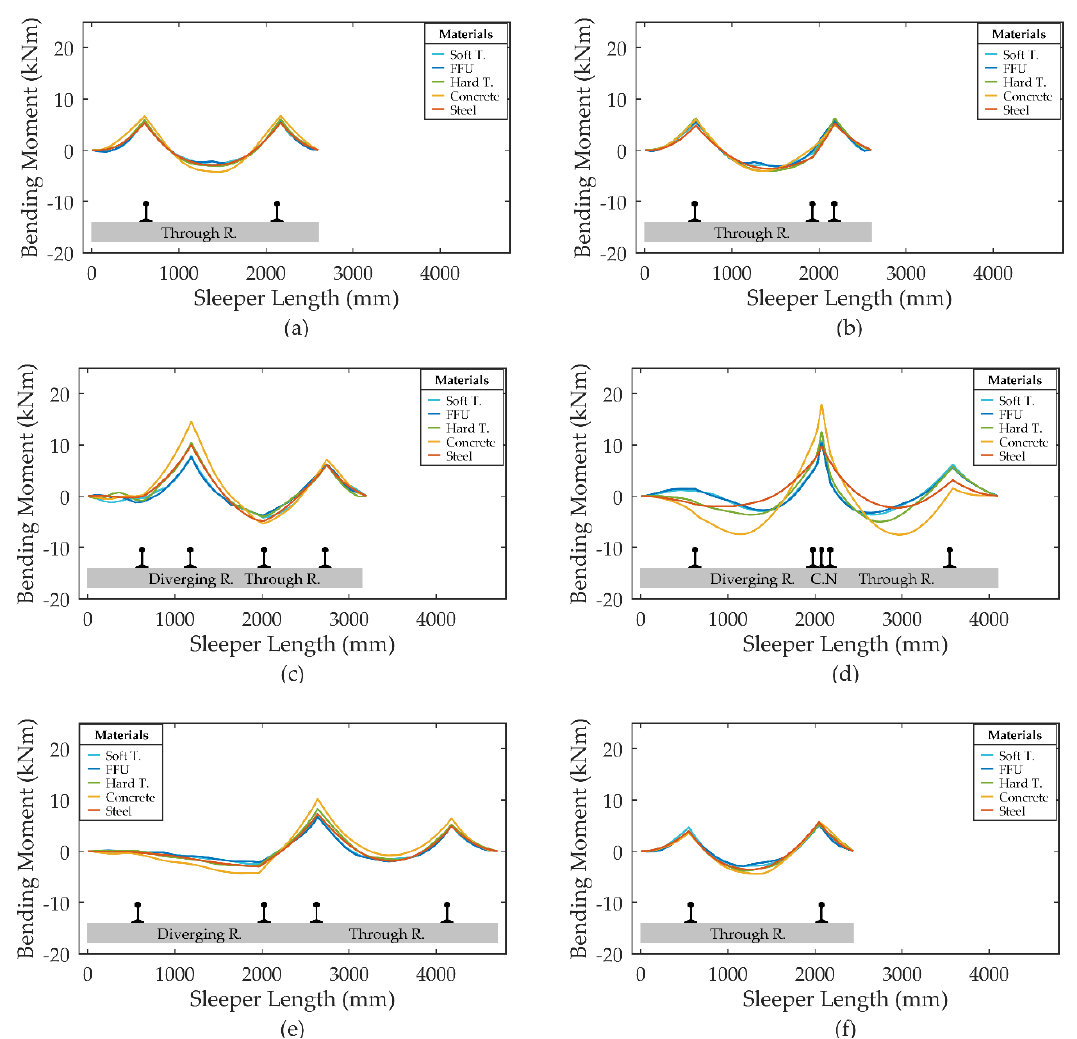
Figure 15. Bending moment distributions of specific sleepers with reference to different sleeper types: ( a ) sleeper at the entrance; ( b ) sleeper under the switch blades; ( c ) sleeper at the closure panel; ( d ) sleeper under the crossing nose; ( e ) the longest sleeper; ( f ) the shortest sleeper.